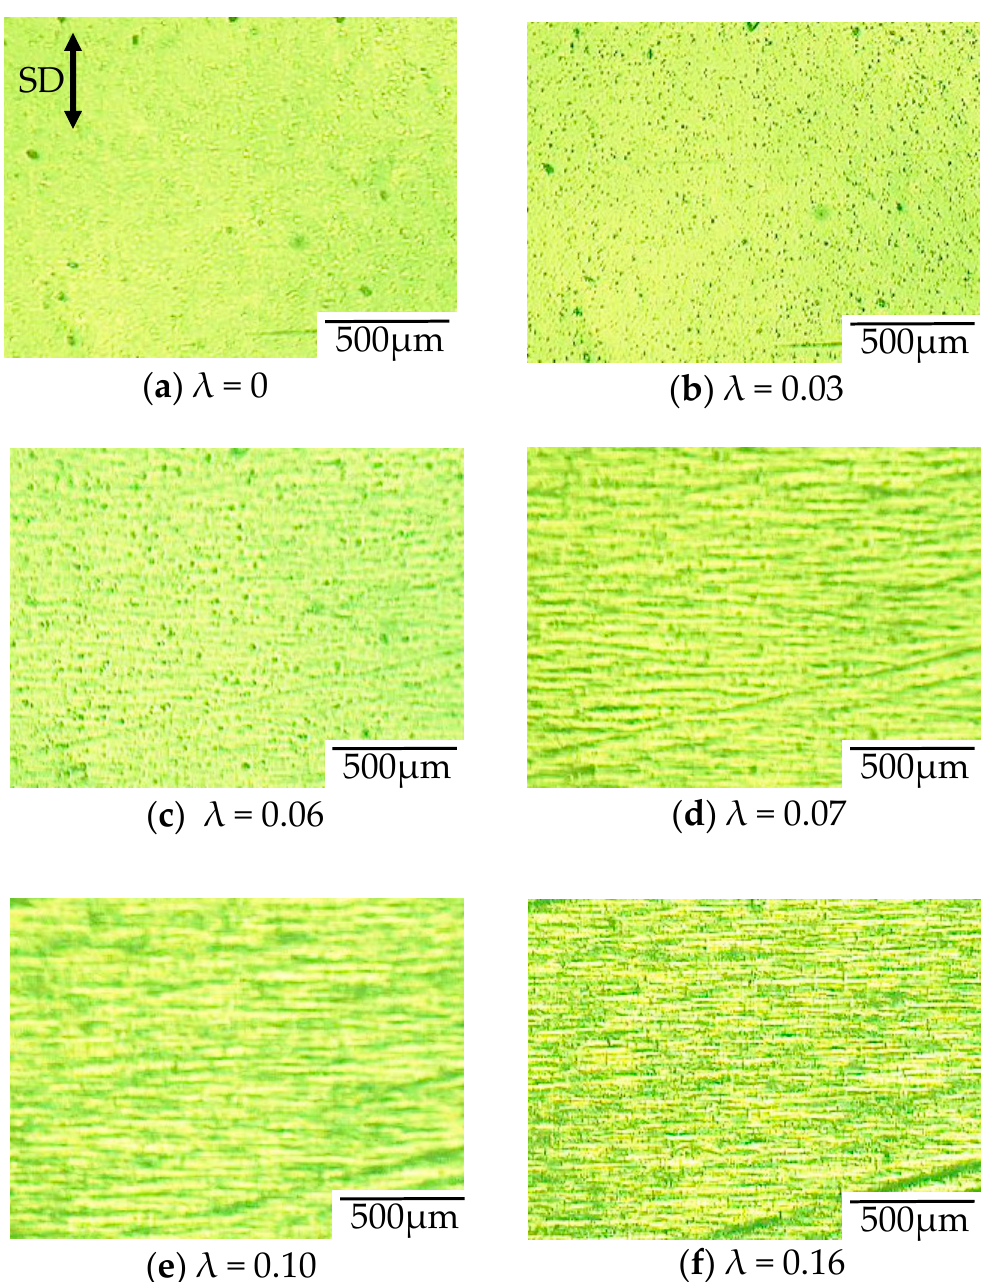
Figure 8. In situ observation for void formation of OD-PC during stretching under CO 2 at 5 MPa. To confirm the evolution of the filament-shaped porous structure suggested by the in situ observation shown in Figure 8, the polarized optical micrographs for the porous structure obtained after stretching at various strains under CO 2 of 5 MPa are shown in Figure 9. A small number of long filament-shaped voids were obtained in the OD-PC matrix around the yielding point (Figure 9a). The interference color around the surface of the voids was different from that at the outer